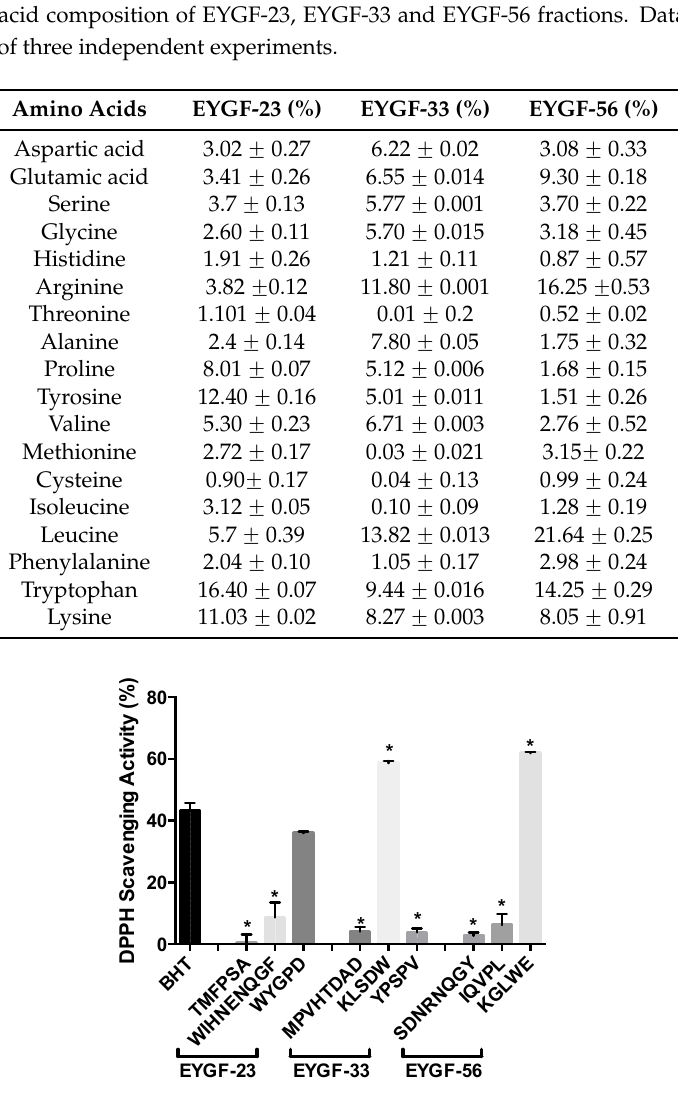
Figure 7. DPPH scavenging activity (%) of selected peptides. The activity was analyzed for 10 mg/mL of all isolated peptides. Data correspond to the means ± SD of three independent experiments. The results were compared with (0.2 mg/mL) butylated hydroxytoluene (BHT). The result was considered statistically significant versus BHT (* = p < 0.05).